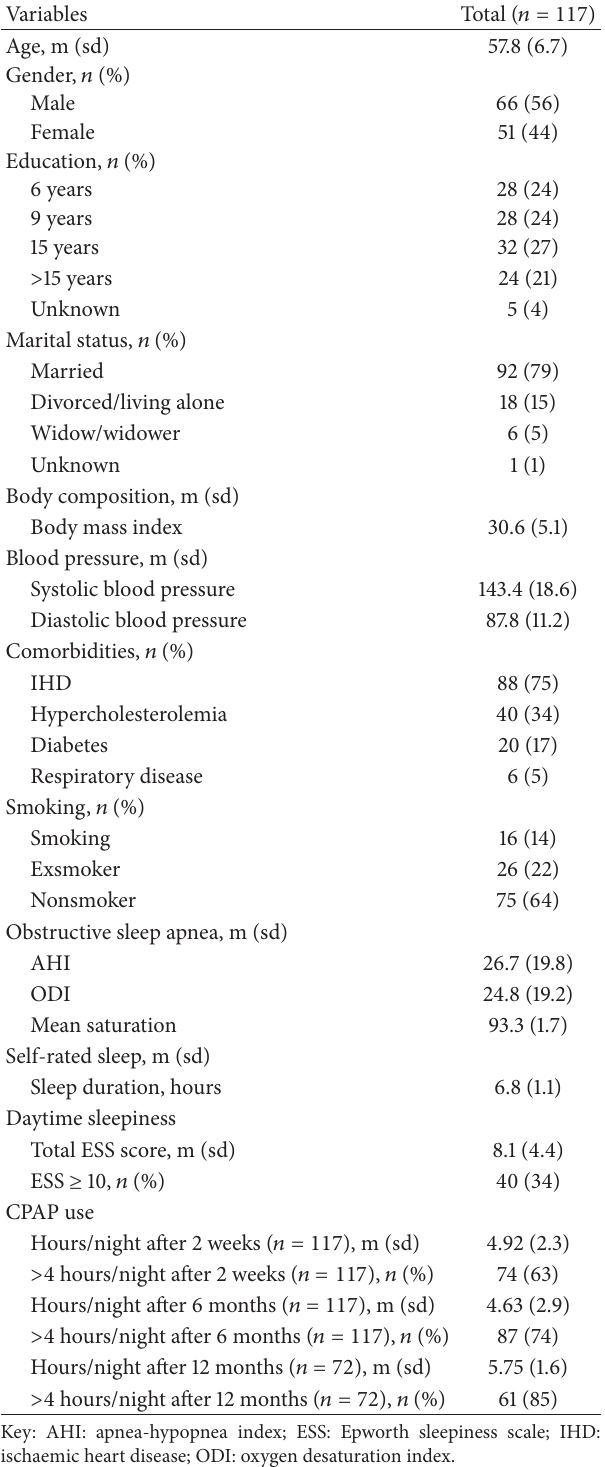
Table 2: Characteristics of the population before treatment initia- tion ( 𝑛 = 117